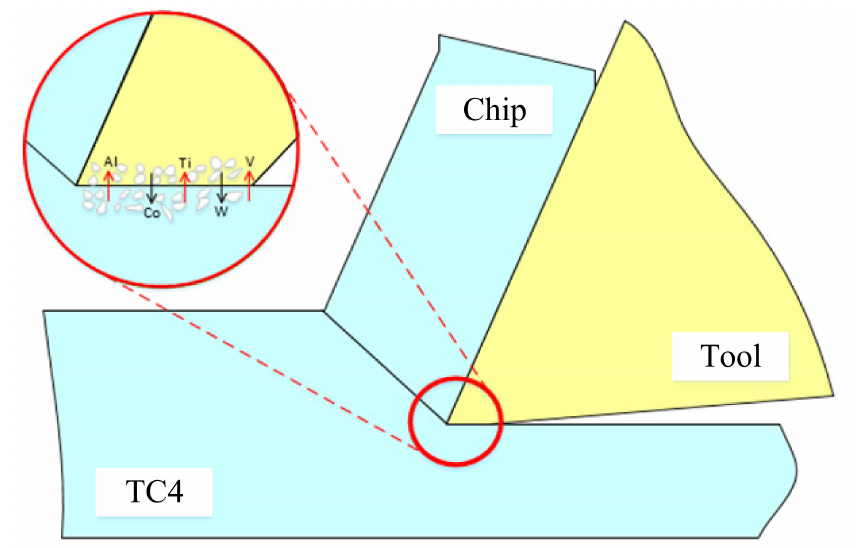
Figure 7. Schematic diagram of di ff usion abrasion of the milling cutter flank